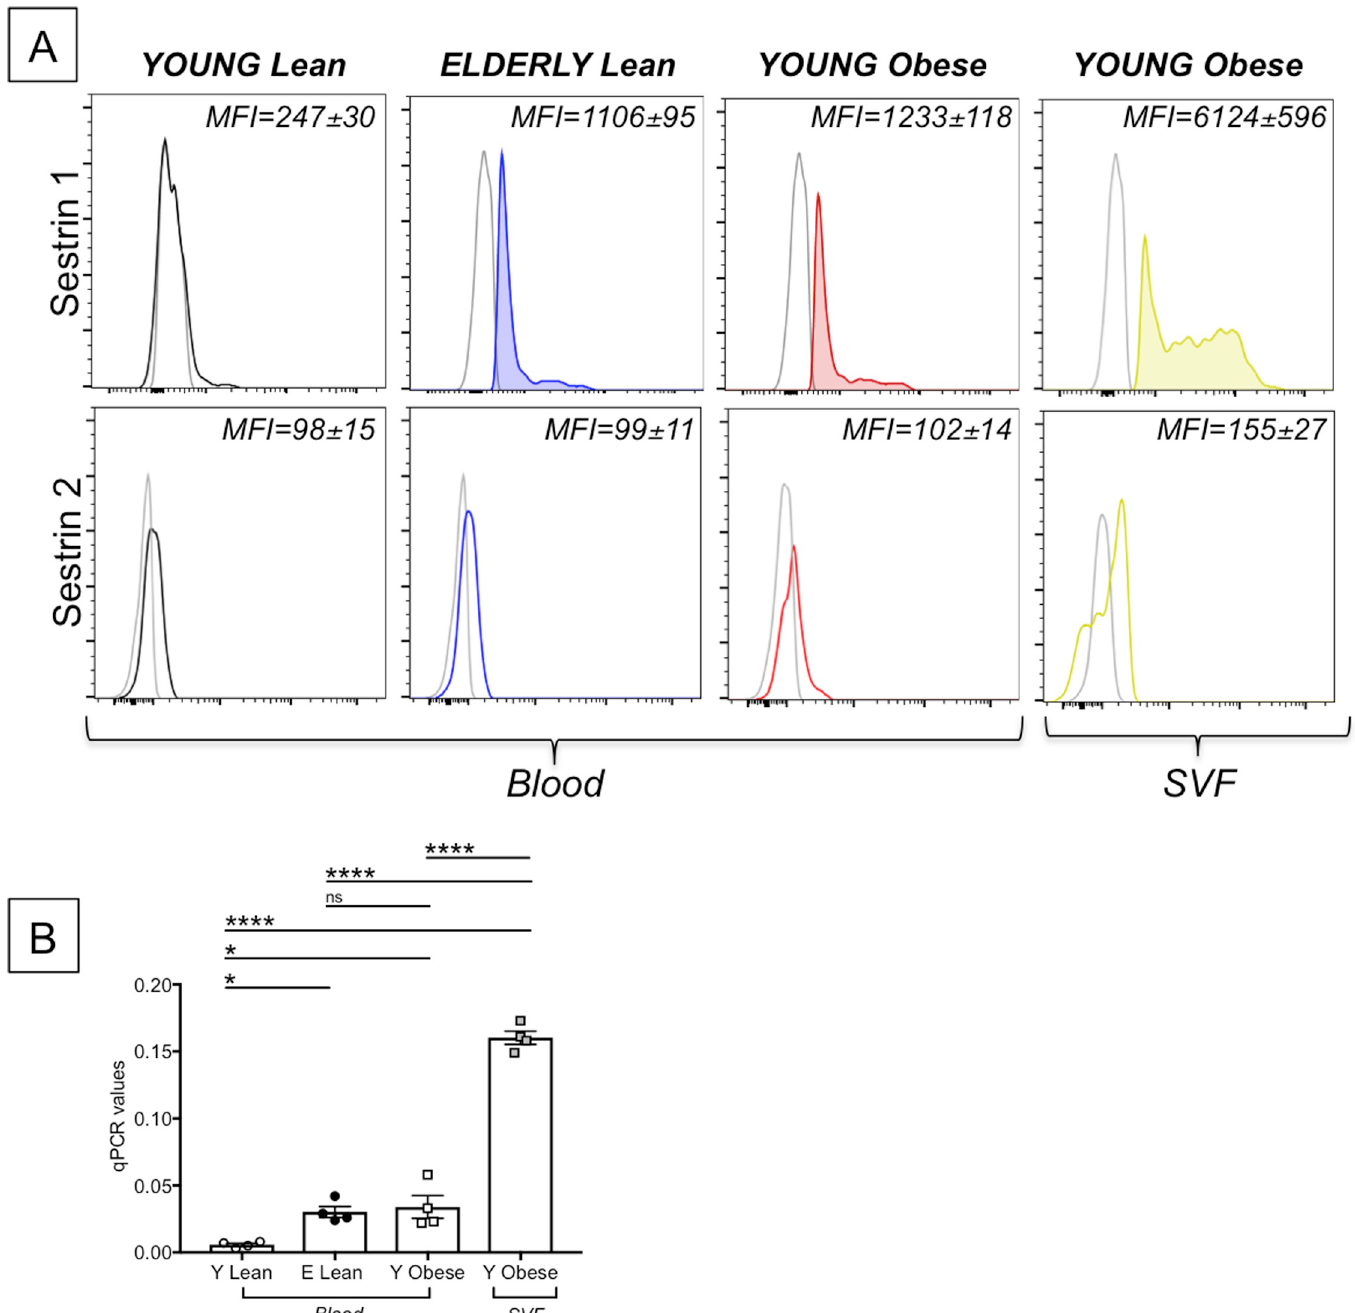
Fig 10. Effects of aging and obesity on Sestrin 1 and Sestrin 2. PBMC and SVF were obtained as indicated previously (n = 4). A. Results show mRNA expression of Sestrin 1 ( top ) and Sestrin 2 ( bottom ), both measured by PrimeFlow. B. qPCR values (2 - ΔΔ Ct ) of Sestrin 1. Mean comparisons between groups were performed by two-way ANOVA. � p < 0.05, ���� p < 0.0001, ns: not